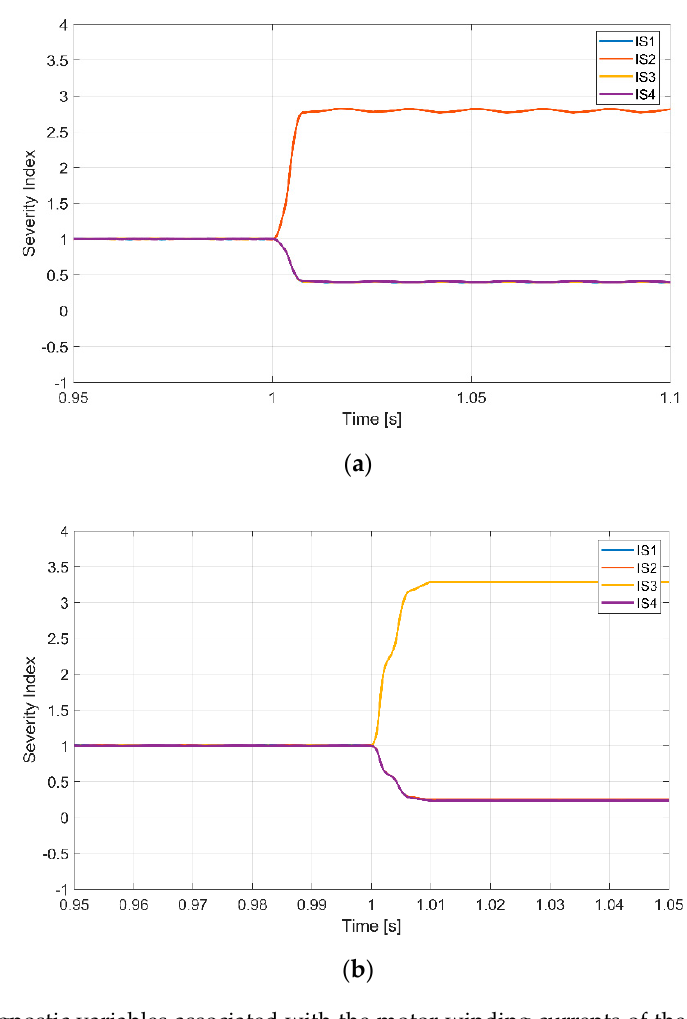
Figure 17. Diagnostic variables associated with the motor winding currents of the SRM in normal operation and short-circuit failure of power device ( a ) 1200 rpm and S 1 B ( b ) 2840 rpm and S 1 C (simulation result).